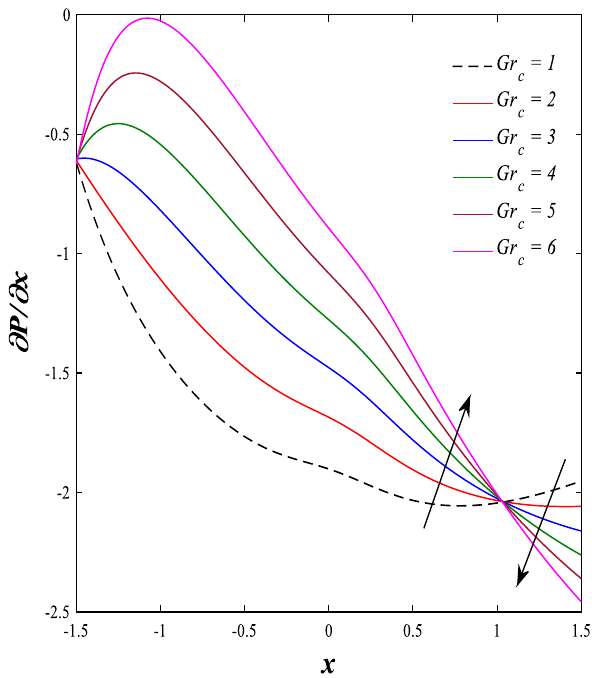
Figure 27. Effect of solutal Grashof number Gr c on the pressure gradients